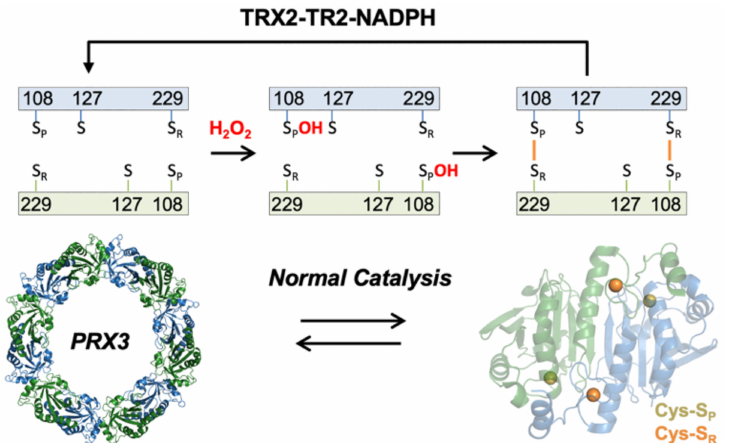
Figure 1. Catalytic cycle of PRX3. Hydrogen peroxide reacts with the peroxidatic Cys residue (Cys108-S P ) to form a Cys-sulfenic acid intermediate (Cys108-S P OH). The resolving Cys residue (Cys229-S R ) then reacts to form a disulfide. Disulfide bond formation facilitates collapse of the dodecamer to form 6 dimers; reduction of the disulfide by the thioredoxin 2-thioredoxin reductase 2-NADPH (TRX2-TR2-NADPH) reducing system shifts the equilibrium back toward dodecamer. Note that each active site can form a disulfide bond in the absence of TS. In the presence of TS, the data herein supports the formation of an asymmetric dimer with 1 disulfide and 1 TS-mediated